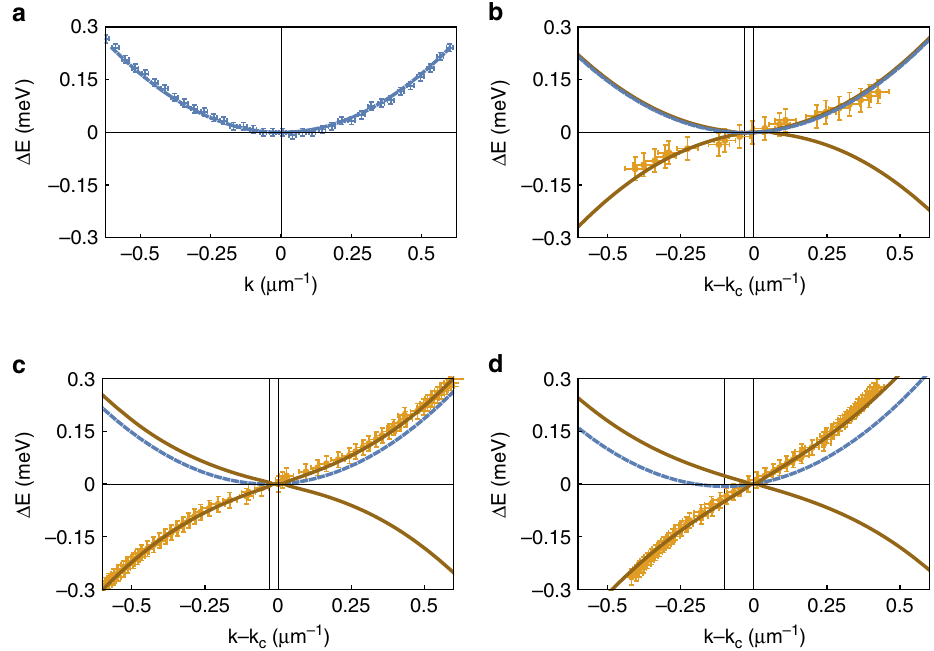
Fig. 3 Dispersion relation for increasing densities. a Parabolic dispersion extracted from PL at densities well below the condensation threshold d th . b – d Excitation spectrum for increasing pumping powers corresponding to P ¼ 0 : 9 P th , P ¼ P th and P ¼ 1 : 5 P th as extracted from the positions of the maxima in Fig. 2b, d, f, respectively. Best- fi t parameters to Eq. (2) are μ ¼ 0 : 005meV, μ ¼ 0 : 04meV and μ ¼ 0 : 1meV in ( b – d ), respectively. The condensate wavevector is k c ¼ 0 : 03 μ m (cid:4) 1 , k c ¼ 0 : 03 μ m (cid:4) 1 and k c ¼ 0 : 1 μ m (cid:4) 1 in b – d , respectively. The dashed-blue lines are the parabolic dispersion relations with the energy and momentum offsets given by μ and k c as obtained from the fi t of Eq. (2) to the data in each panel. The mass is extracted from the parabolic fi tting of the data in ( a ). Γ ¼ 0 : 005 ps (cid:4) 1 is used in ( b – d ).